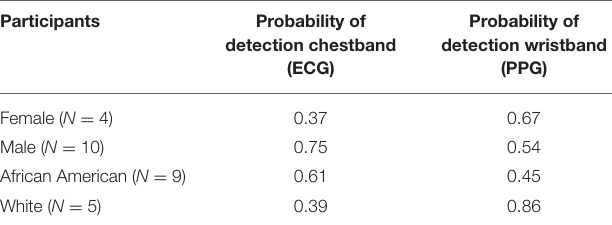
TABLE 9 | Probability of detection of EMA events by gender and